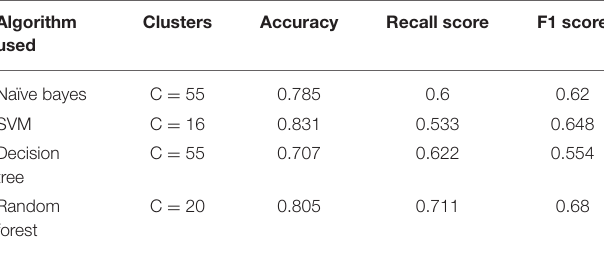
TABLE 4 | Evaluation attributes results for the different models (Pima Indian).